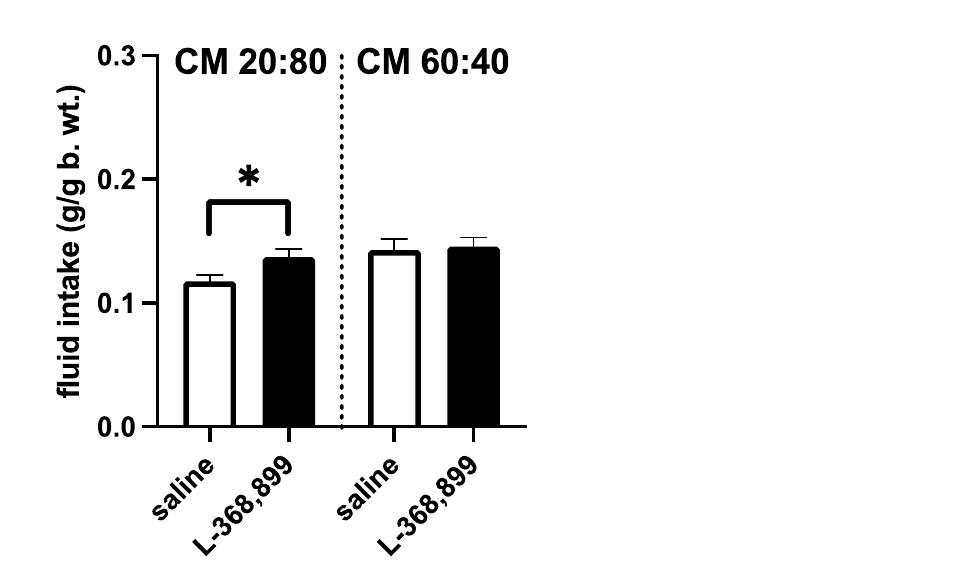
Figure 5. Intake of the individually presented natural Control (20:80 whey:casein) CM and the whey-adapted (60:40 whey:casein) CM in non-deprived mice during 3-h access to the diets. Ten minutes before the meal, the animals were injected with isotonic saline or a blood brain barrier-penetrant OT receptor antagonist, L-368,899 (1 mg/kg). Intake was measured at 3 h. * p ≤ 0.05.